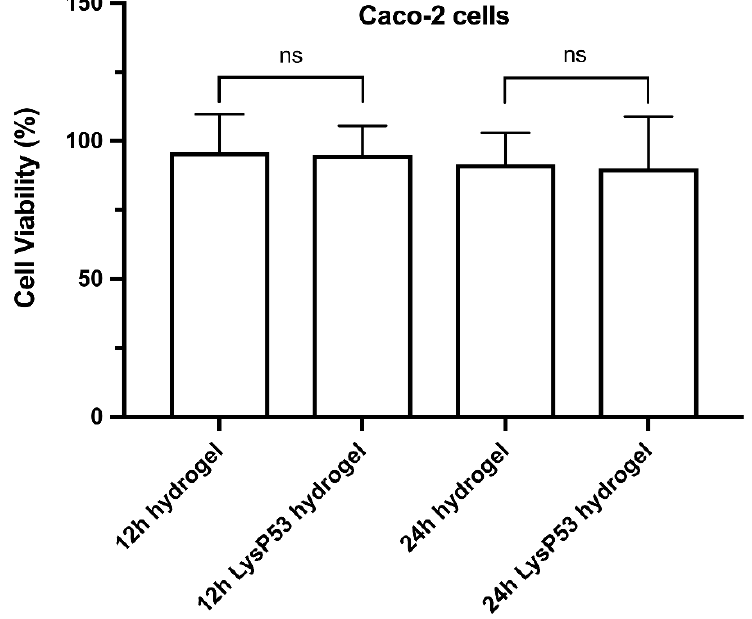
Figure 4. Relative viability of Caco-2 cells exposed to different release times of hydrogel only and LysP53-loaded hydrogel. A >90% cell viability was maintained at all conditions and times. Ns – not significant.